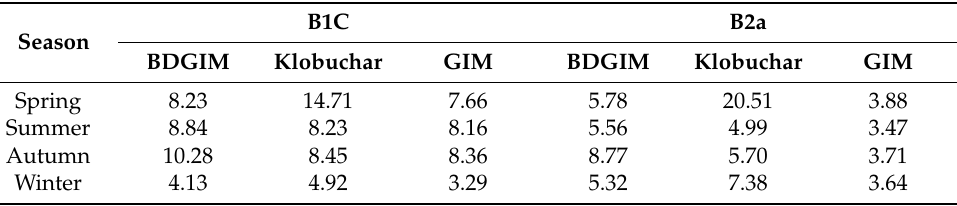
Table 6. The average 3D positioning accuracies of different models for novel BDS signals in different seasons (unit: m). B1C B2a Season BDGIM Klobuchar GIM BDGIM GIM Spring Table 7. The average 3D positioning accuracies of different models for old BDS signals in different seasons (unit: m). B1I B3I Season BDGIM Klobuchar GIM BDGIM Klobuchar GIM Spring